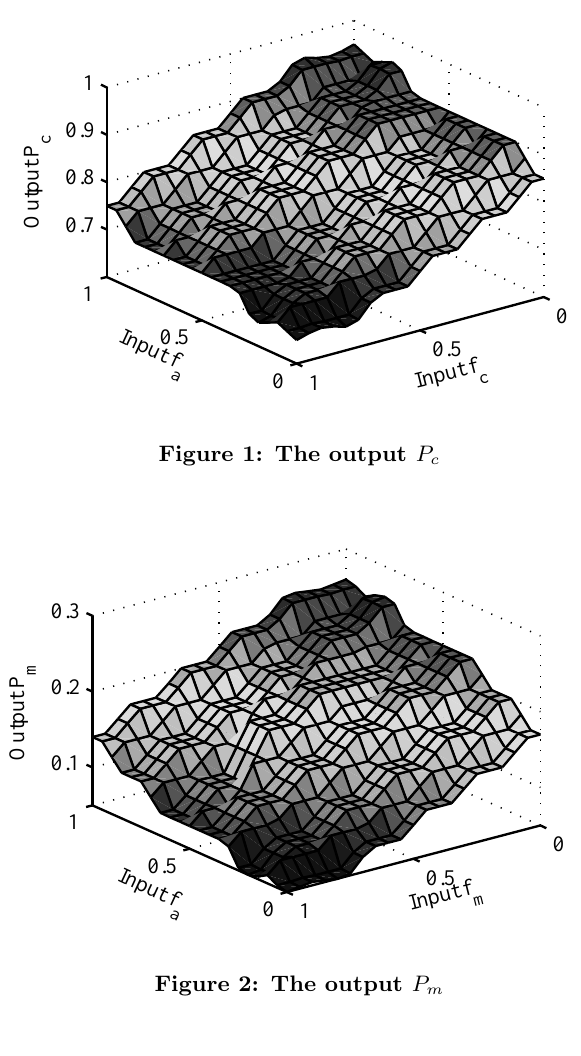
Figure 2: The output P